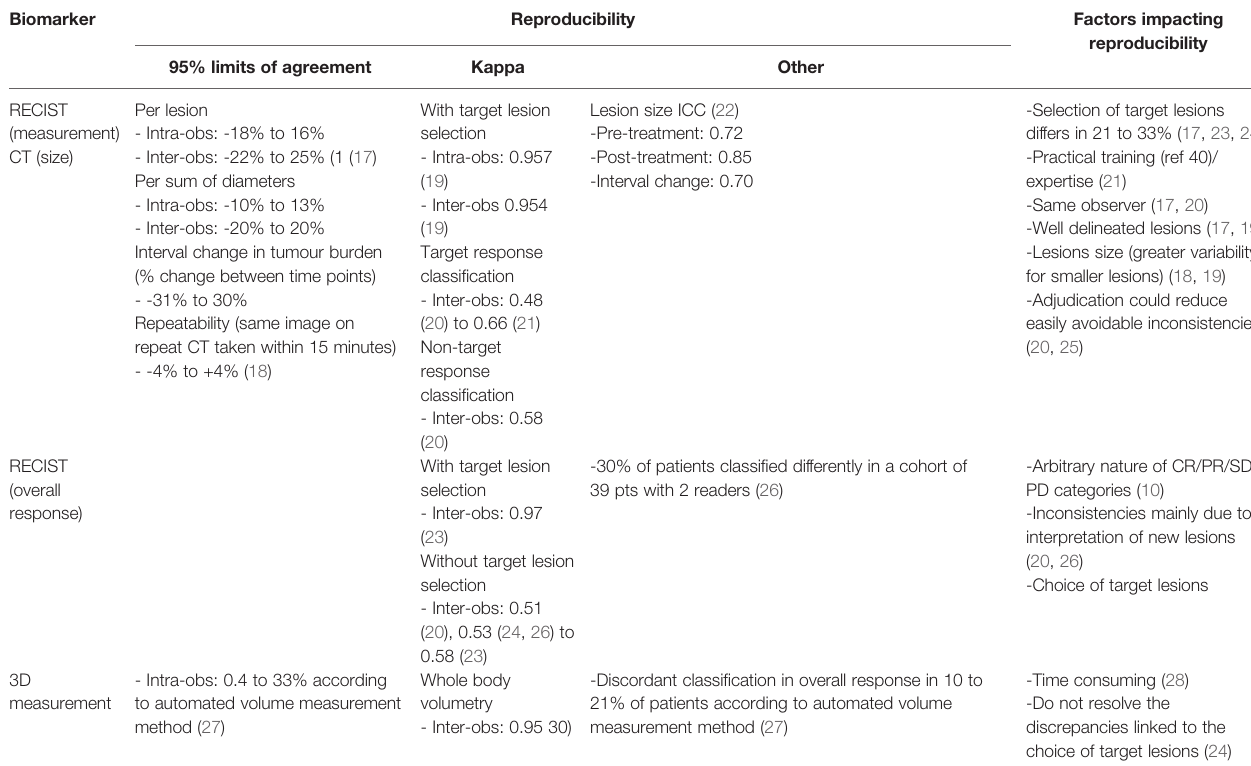
TABLE 3 | RECIST reproducibility and factors impacting